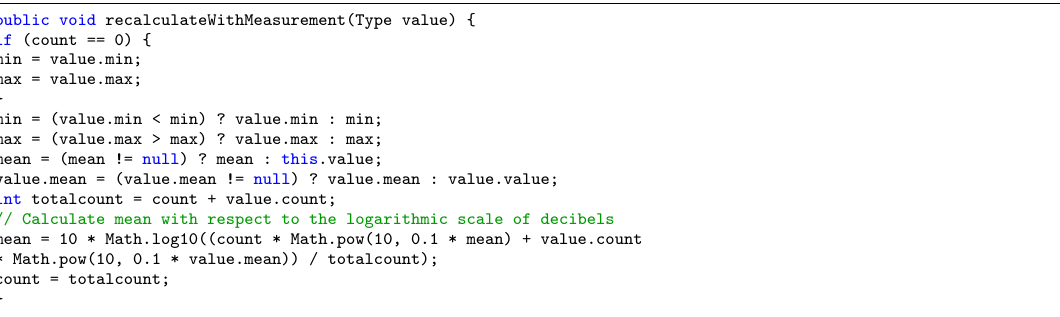
Figure 9. Class method that recalculates the minimum, maximum, and mean values of a